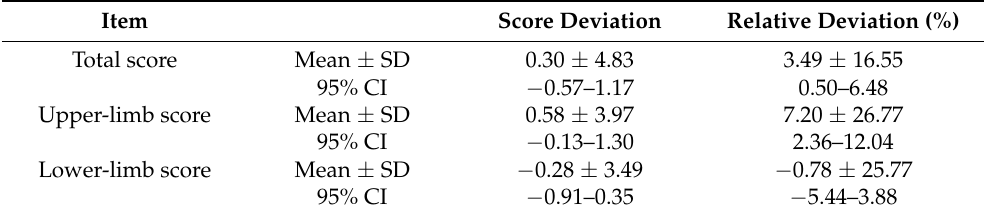
Table 4. The score deviation and relative deviation (%) of the intelligent rehabilitation assessment system and the physician’s FMA score.